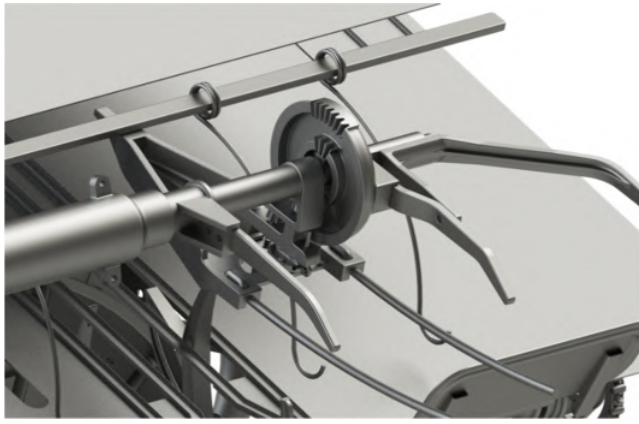
Figure 24. Elements of the knotter.